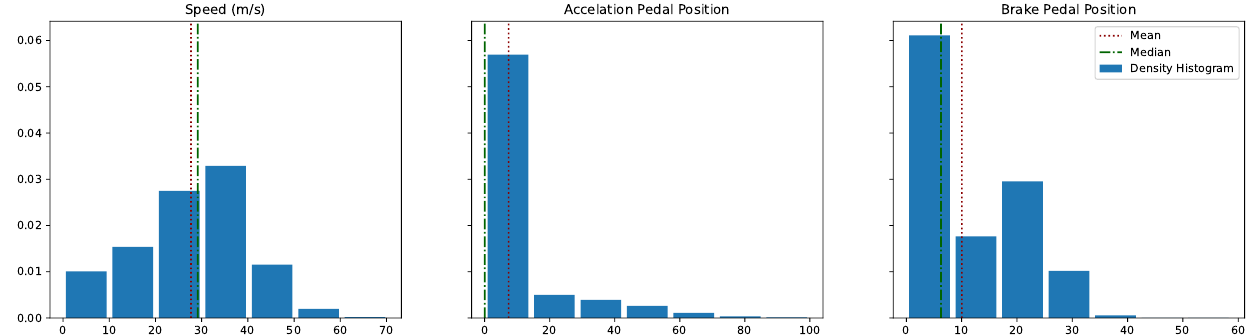
Figure 3. Density histogram, median and mean for the speed, acceleration pedal position, and brake pedal position values for the data point on the traffic light approach sequences (all the data used for determining AH values). Brake and acceleration pedal positions have a possible value range from 0 to